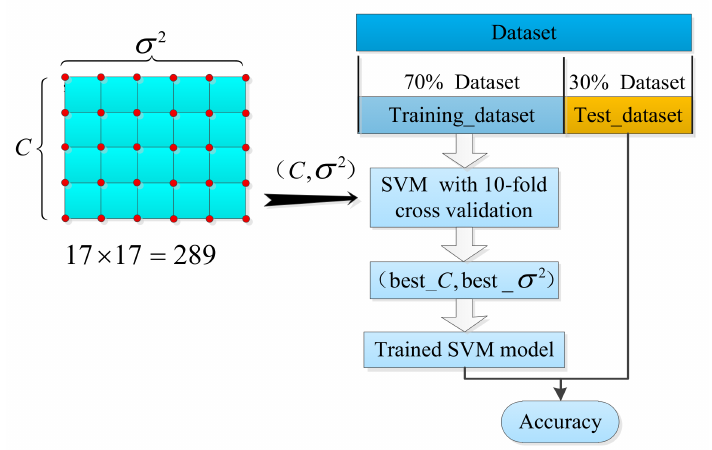
Figure 12. The process of PMDCM’s fault diagnosis by utilizing the SVM classifier.